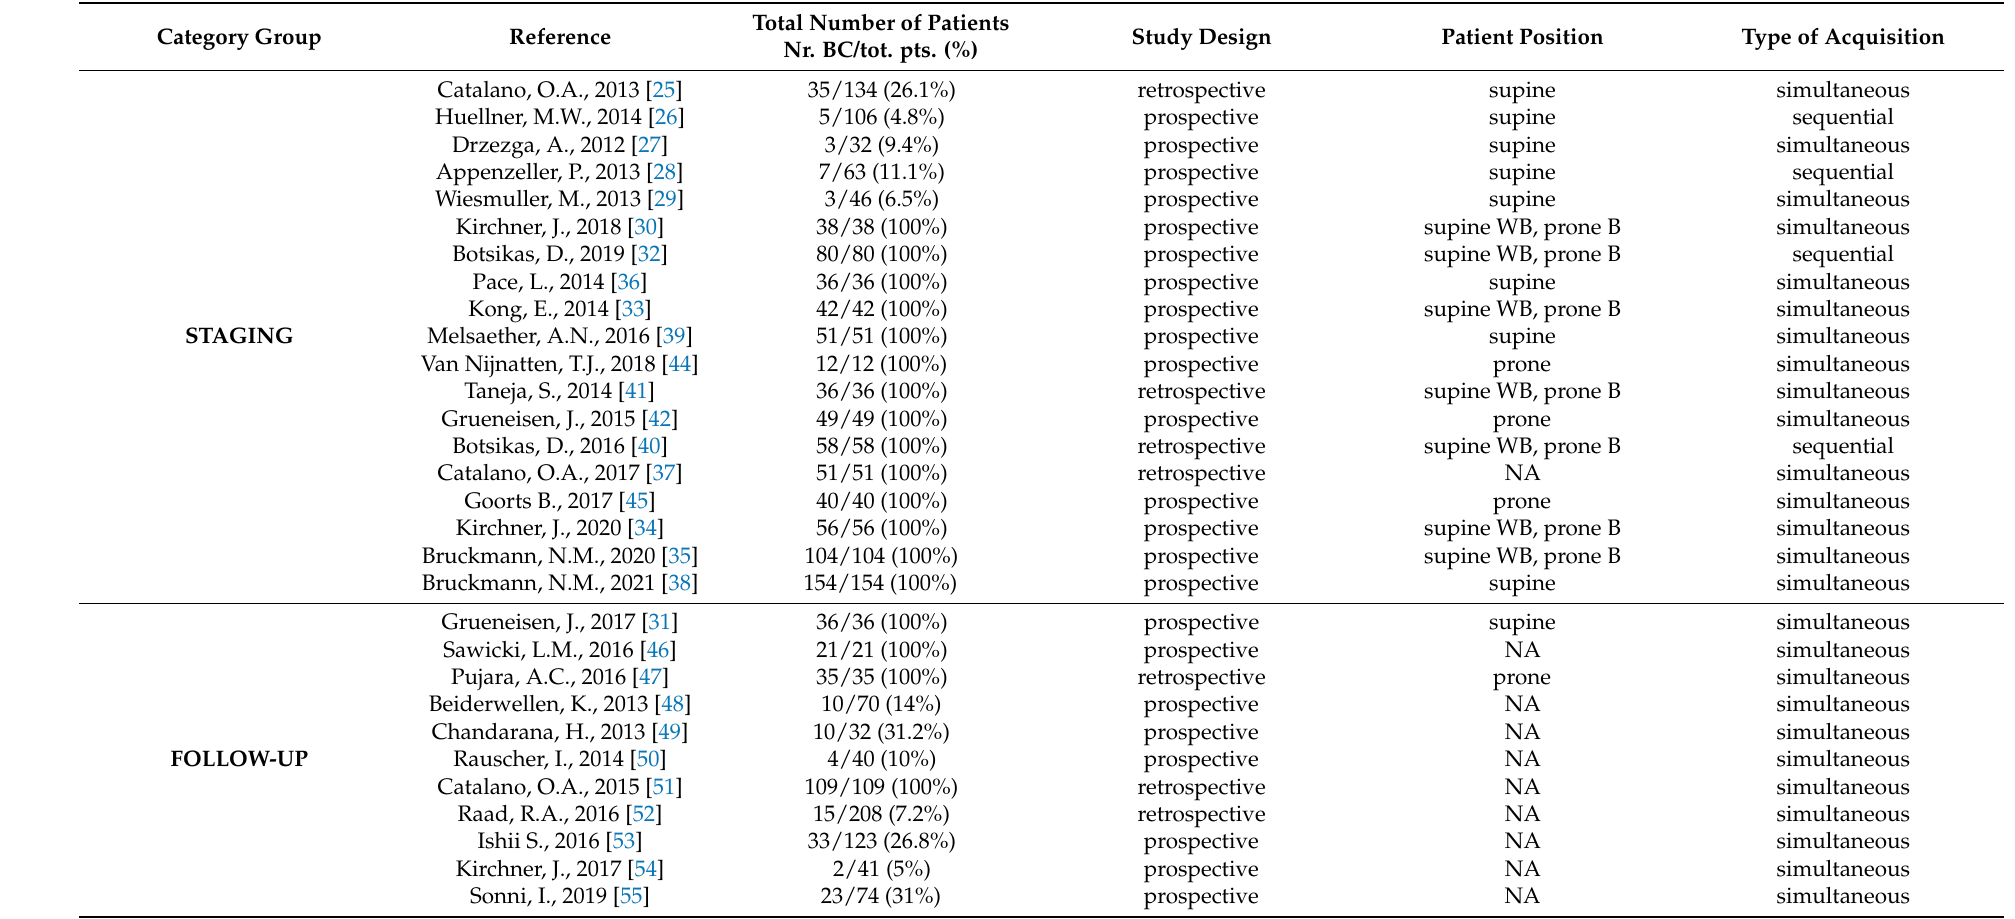
Table 1. Previous studies on PET/MRI in breast cancer patients divided according to the main objective of the exam into four groups: staging, follow-up, prognosis and response to therapy. (Nr.BC/Tot pts.: Number of breast cancer patients/total patients; NA: not available; WB: whole-body PET/MRI; B: breast